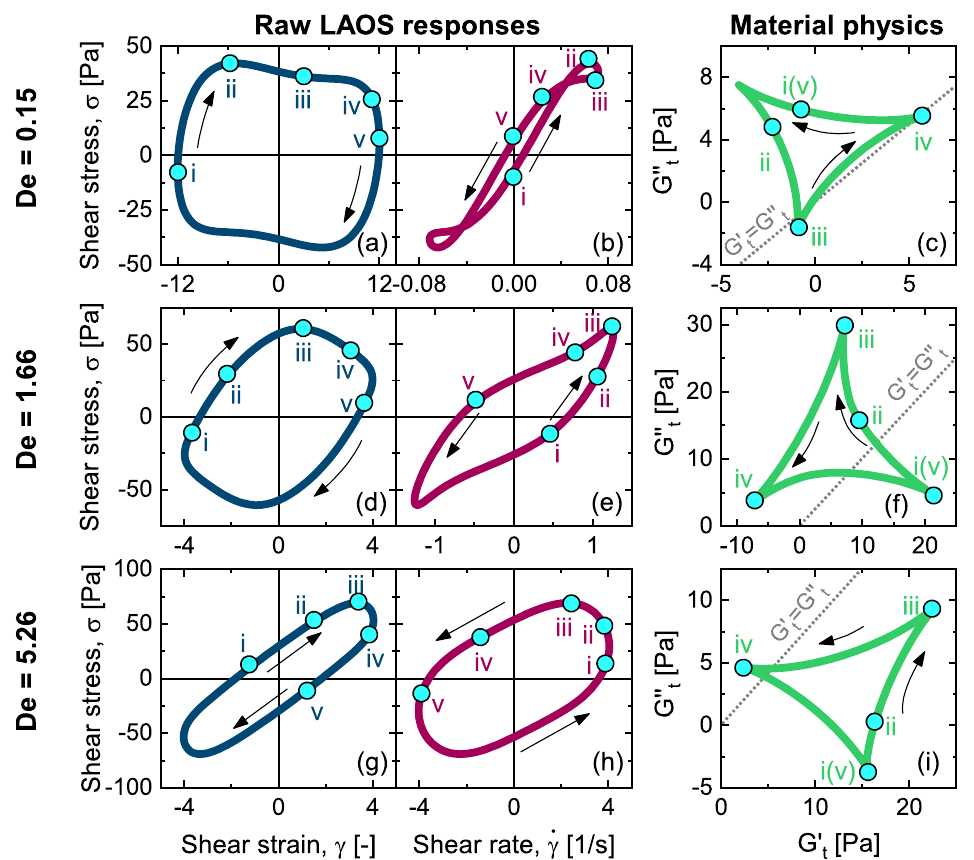
Figure 4. Raw large-amplitude oscillatory shear (LAOS) responses and associated material physics. ( a , d , g ) Elastic Lissajous curve of shear stress versus shear strain; ( b , e , h ) Viscous Lissajous curve of shear stress versus shear rate. ( c , f , i ) Physical interpretation of LAOS responses constituted by plotting time-dependent viscous modulus versus time-dependent elastic